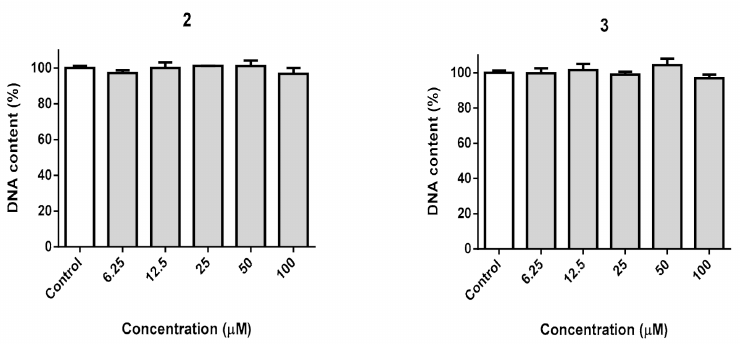
Figure 10. DNA content of HaCaT cells treated with CNB-Phe- ∆ Phe-OH ( 2 ) and H-Phe- ∆ Phe-OH ( 3 ) for 24 h, at the concentrations